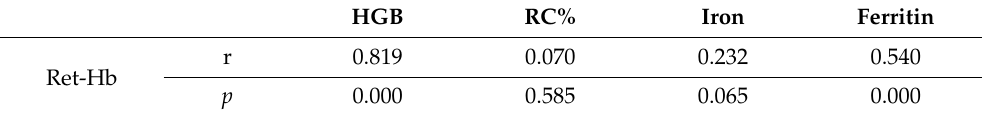
Table 4. Correlation of reticulocyte hemoglobin content with other parameters among IDA patients.